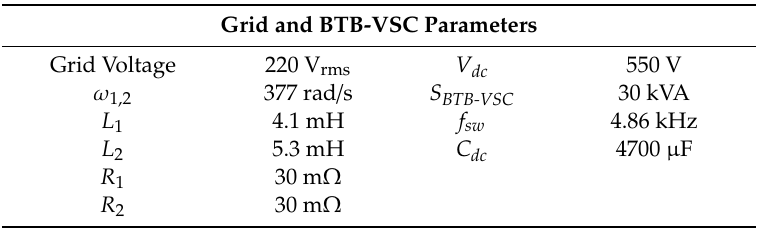
Table 2. Power system